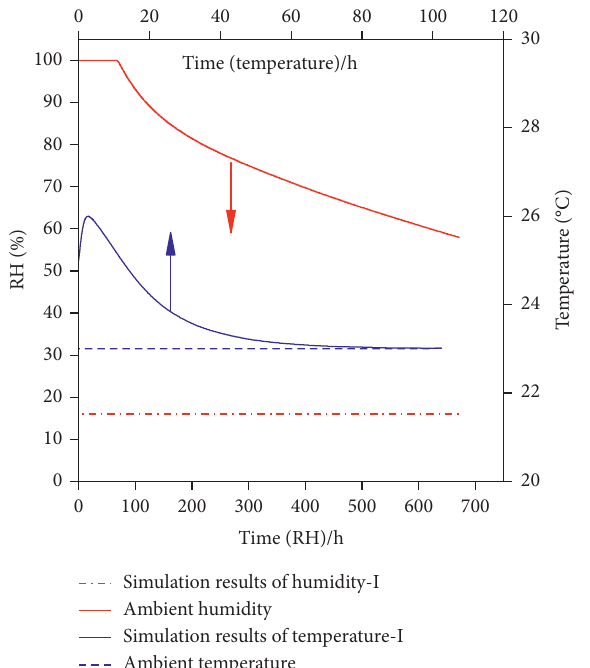
Figure 9: Development of interior humidity and temperature with age.